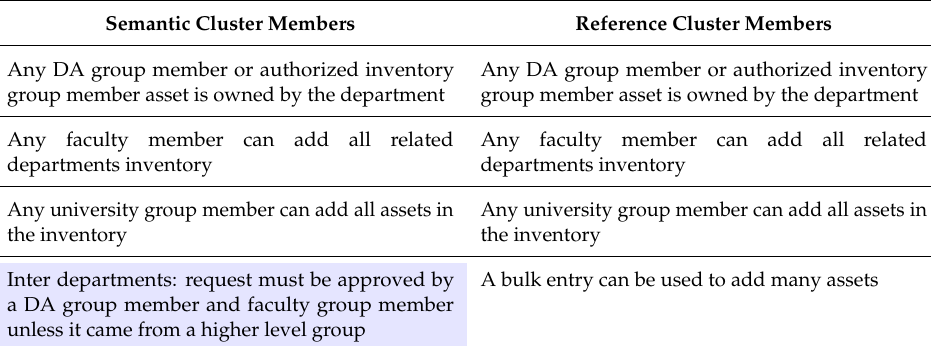
Table 8. An example of a semantic cluster identified from a UUIS